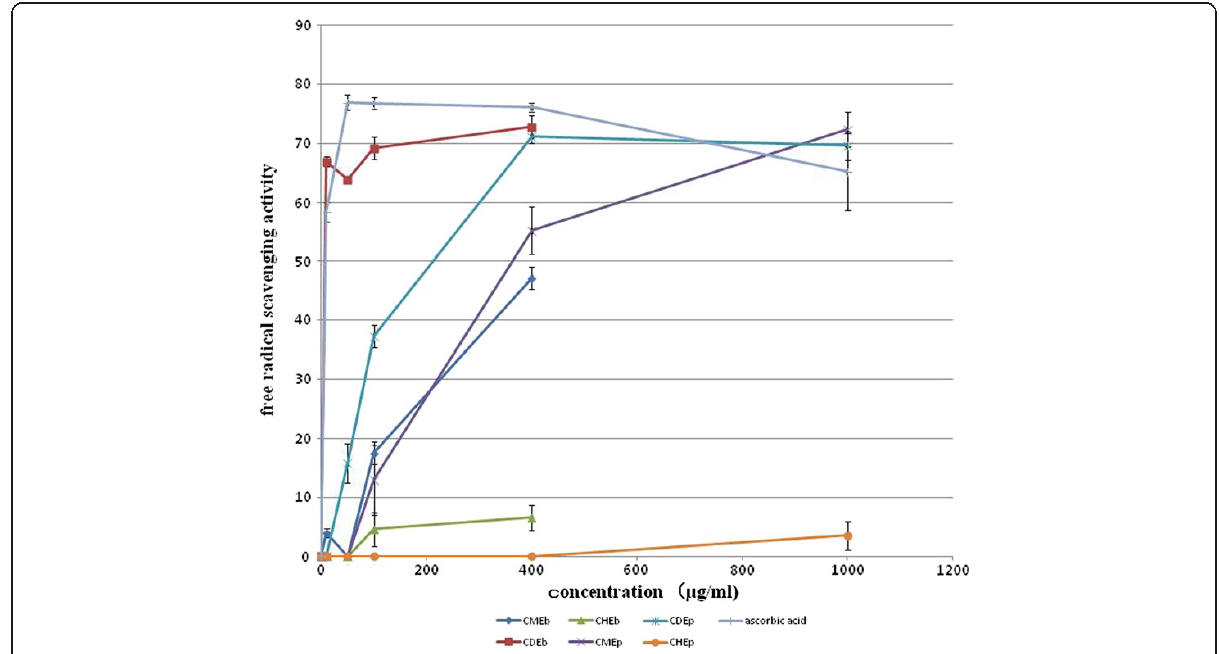
Figure 2 Free radical scavenging activity of the crude solvent extracts of bee pollen and corn pollen. A. mellifera bee pollen and corn pollen were extracted sequentially with methanol (CMEb, CMEp), DCM (CDEb, CDEp) and hexane (CHEb, CHEp) prior to assaying for free radical scavenging activity using the DPPH assay in comparison to the reference standard of ascorbic acid. Data are shown as the mean ± 1 SEM, derived from three independent repeats. Means with a different letter are significantly different ( p <